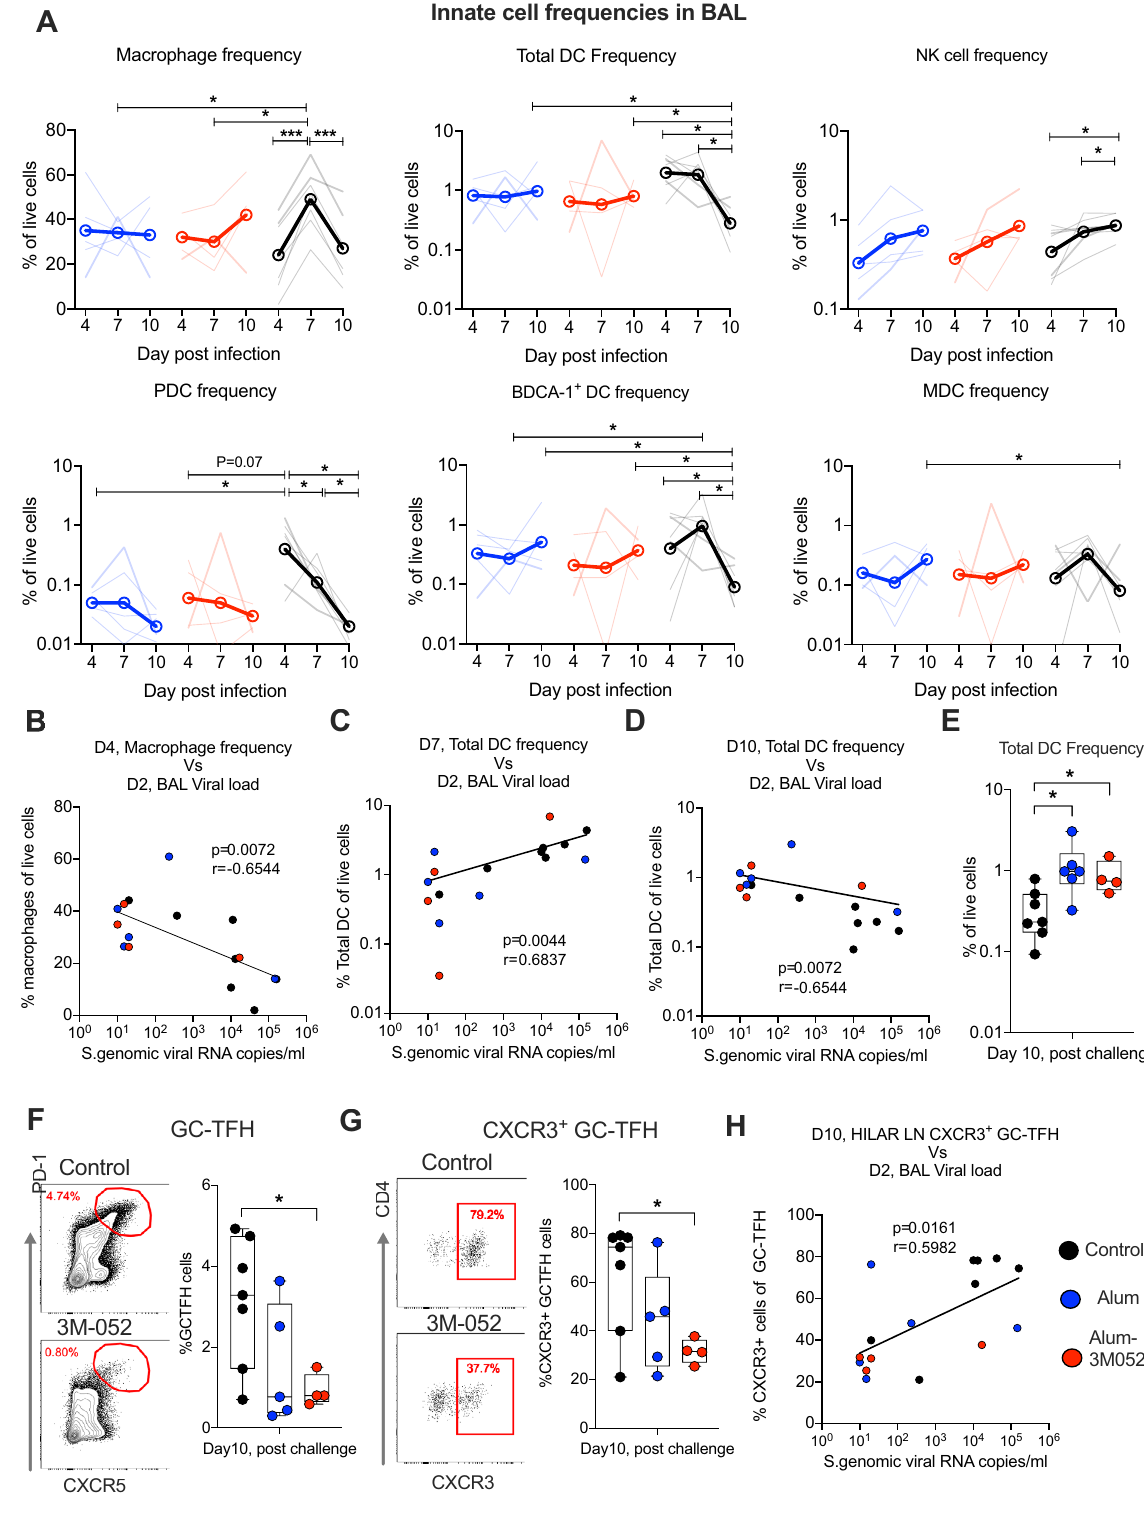
(Figs. 6 and S5). For innate cells we studied macrophages, three subsets of DC (PDC, BDCA-1 + , and MDC), and NK cells on Days 4, 7, and 10. Among the total cells, the macrophages represented the majority with frequencies ranging from 10% to 70%, and the DC (HLA-DR + cells without macrophages) and NK cells represented 0.1 – 1% (Fig. 6A). In controls, the frequency of macrophages increased from Day 4 to Day 7 and returned to Day NATURE COMMUNICATIONS| (2021) 12:3587